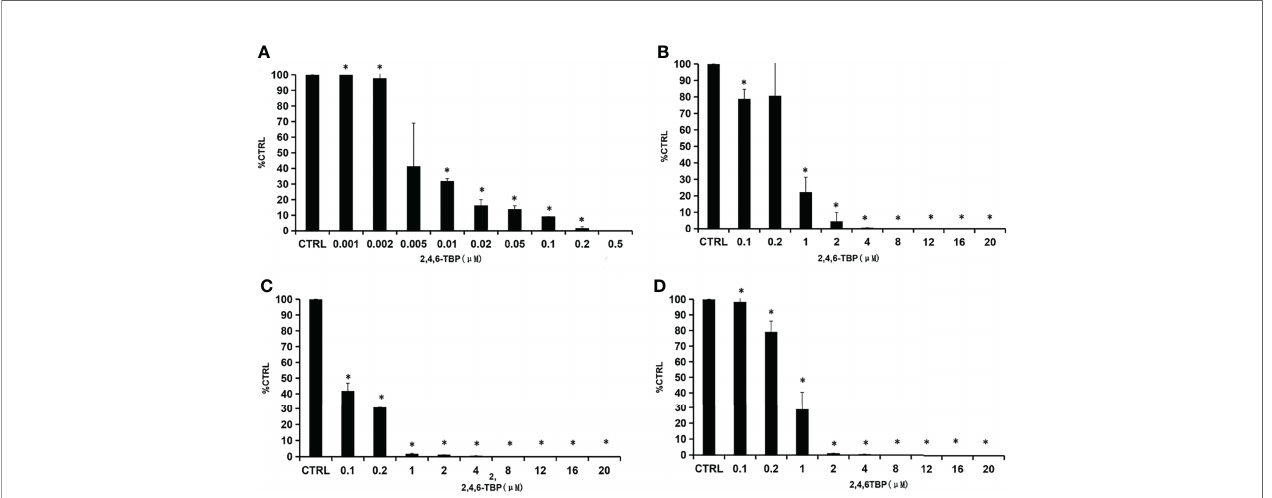
FIGURE 2 | Concentration-dependent inhibition of 2,4,6-TBP towards SULTs. (A – D) presents concentration-dependent inhibition of 2,4,6-TBP towards SULT1A1 (A) , SULT1A3 (B) , SULT1B1 (C) and SULT1E1 (D) .The data were given as mean value plus S.D. (n=3). *p <